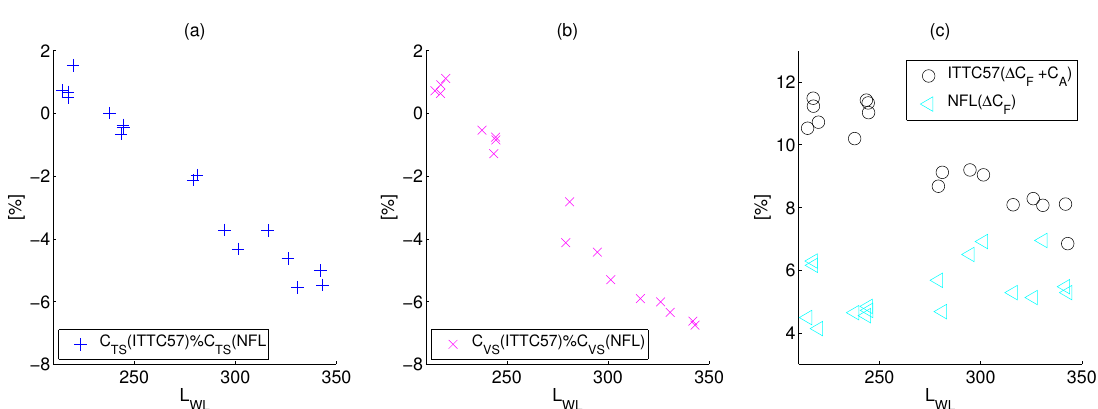
Figure 18. Difference between the ( a ) C TS , ( b ) C VS (including ∆ C F + C A ), and ( c ) ∆ C F + C A predictions using the CFD based form factors with the EASM turbulence model and different friction